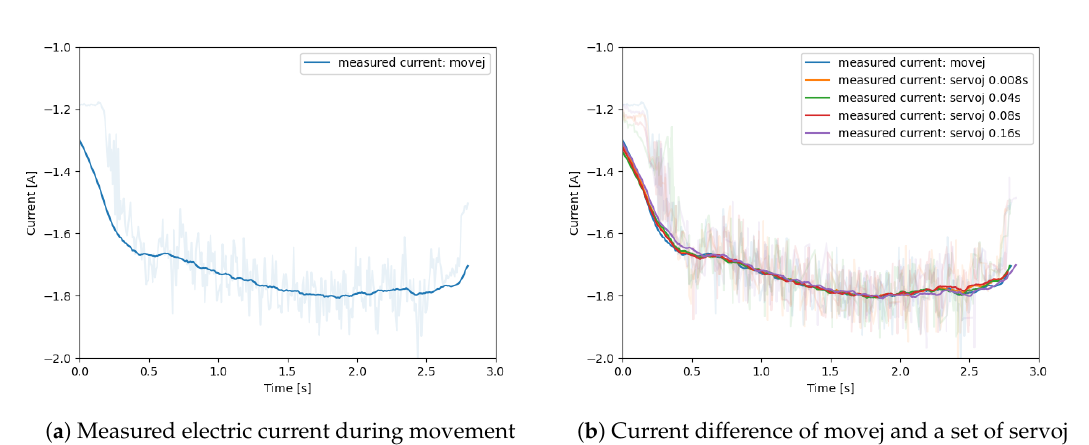
Figure 7. Electric current deviation of the 2nd joint (shoulder) between measurements with different movement prescription during the movement A (Figure